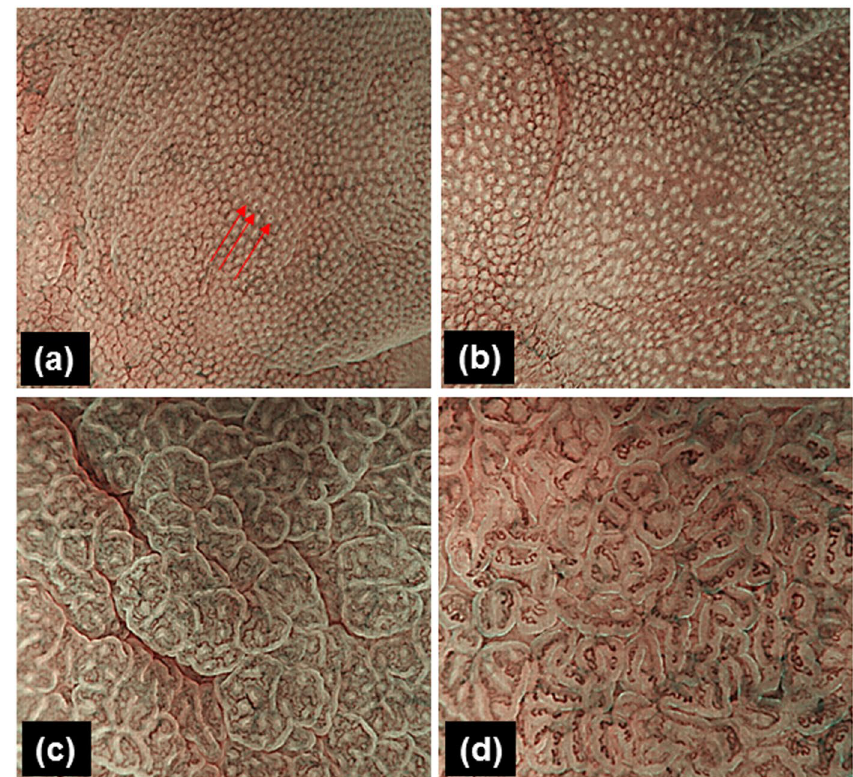
Figure 1. Typical cases of 1 normal and 3 gastric mucosal patterns in the corpus seen with magnifying NBI endoscopy (Tahara et al . Gastrointest Endosc. 2009;70:246-53). Normal: small, round pits surrounded by subepithelial capillary networks (red arrows). Type 1: slightly enlarged, round pit with unclear or irregular subepithelial capillary networks. Type 2: obviously enlarged, oval or prolonged pit with increased density of irregular vessels. Type 3: well-demarcated, oval or tubulovillous pit with clearly visible coiled or wavy vessels. subepithelial capillary networks.